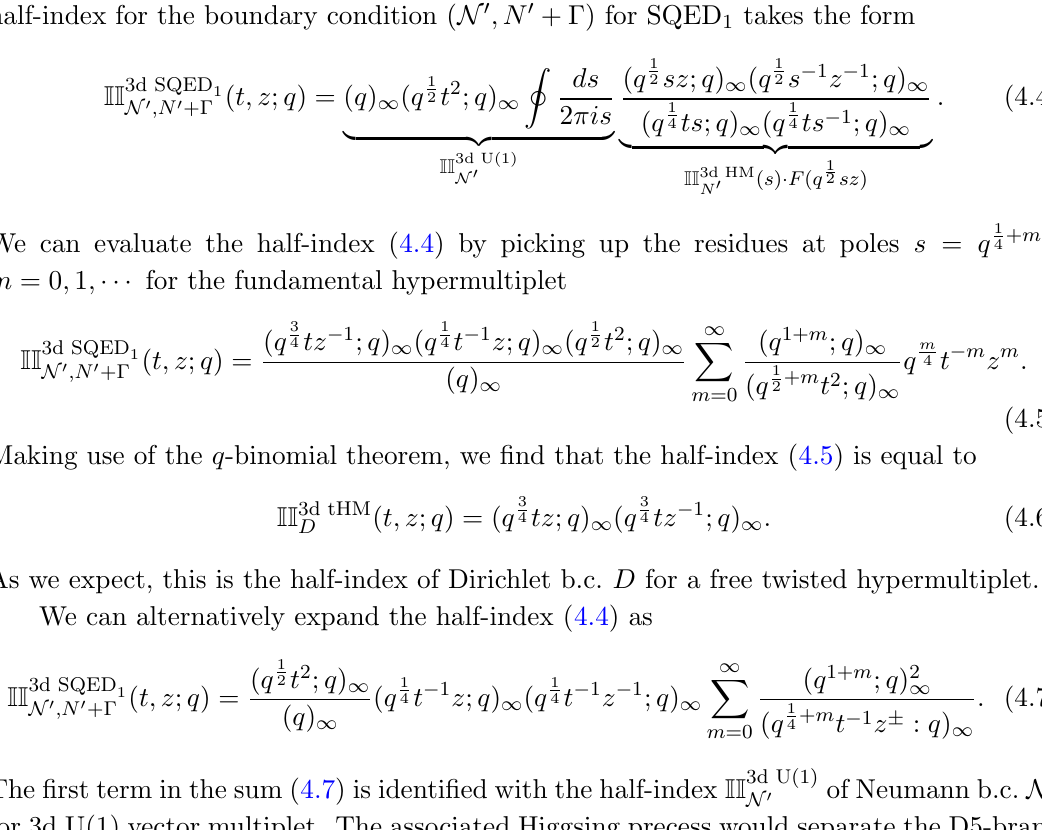
, N (cid:31) + Γ) for SQED 1 that separates the N (cid:31)